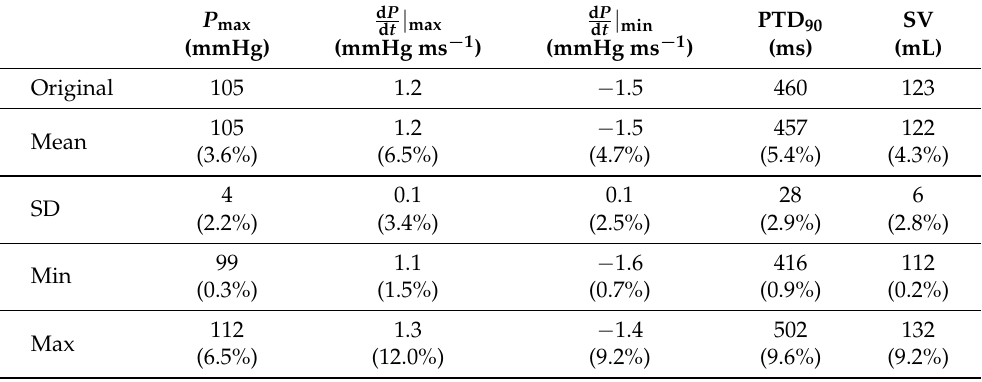
Table 4. Results of the clinical data uncertainty robustness analysis for the patient case 02-CoA. LV pressure and volume biomarker values of the first step of the active mechanics personalisation approach are given. The original values are listed in the first row and means (M), standard deviations (SD), minima (Min), and maxima (Max) of ten samples are listed in the subsequent rows. Means, standard deviations, minima, and maxima of the relative differences are given in brackets below. | P max d P d t